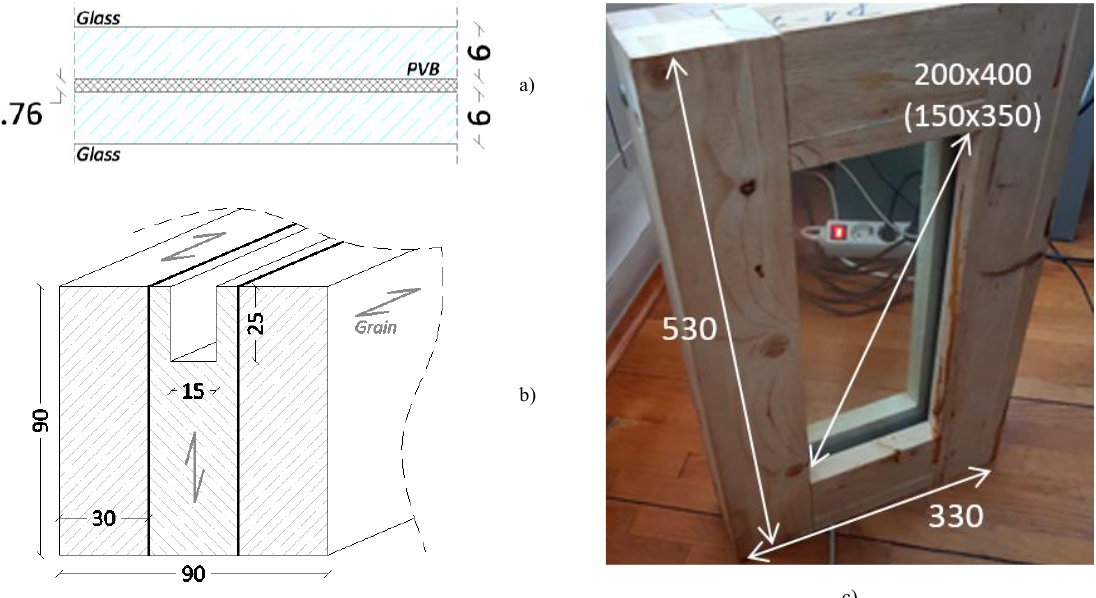
Fig. 3 Small-scale specimens: a) nominal cross-section detail for laminated glass and b) CLT frame members, with c) final assembly (dimensions in